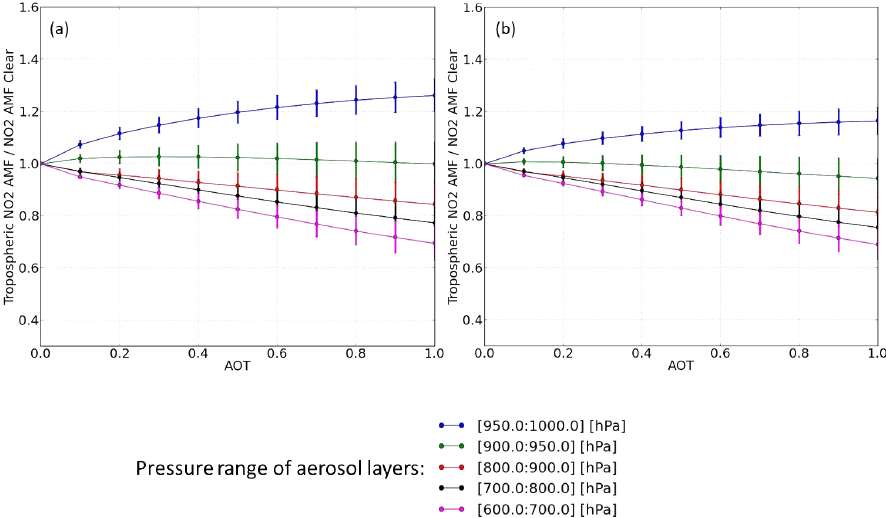
Figure 3. Ratio ( f ) of AMFs at 439nm (see Eq. 5) as a function of AOT and aerosol layer altitude for surface albedo = 0.05 (a) and 0.07 (b) . The f is determined for all the NO 2 vertical profiles from TM5 simulations over East China, July 2006 (see Fig. 1), SZA = 25 ◦ , VZA = 25 ◦ , aerosol Ångström coefficient = 1.5, SSA = 0.95, and asymmetry parameter = 0.7 for the Henyey–Greenstein phase function. The curves connect the average values per AOT bin and the error bars represent the standard deviation of f computed for all the individual TM5 NO 2 profiles over this period and this